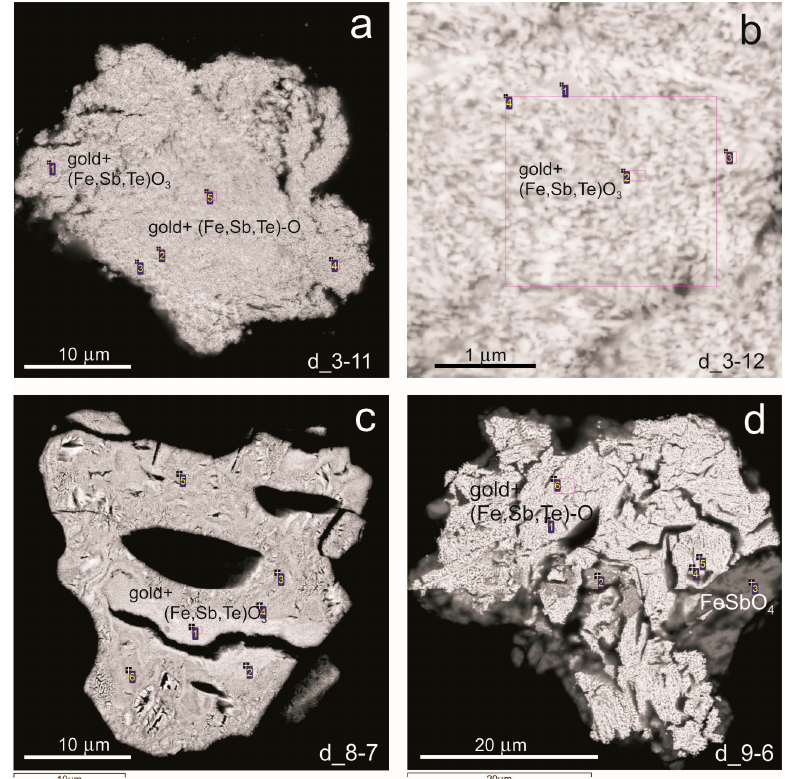
Figure 4. SEM image of mustard (secondary) gold of porous ( a , b , d ) and colloform (concentrically banded), ( c ) textural intergrowth with Fe-(Sb,Te,As,Bi,S)-O compounds. The compositions of compounds or mixtures in the analyzed sites are presented in Table 3. d_9-6 spot 3 (FeSbO 4 )—tripuhyite. The purple square is scan of analytical area.